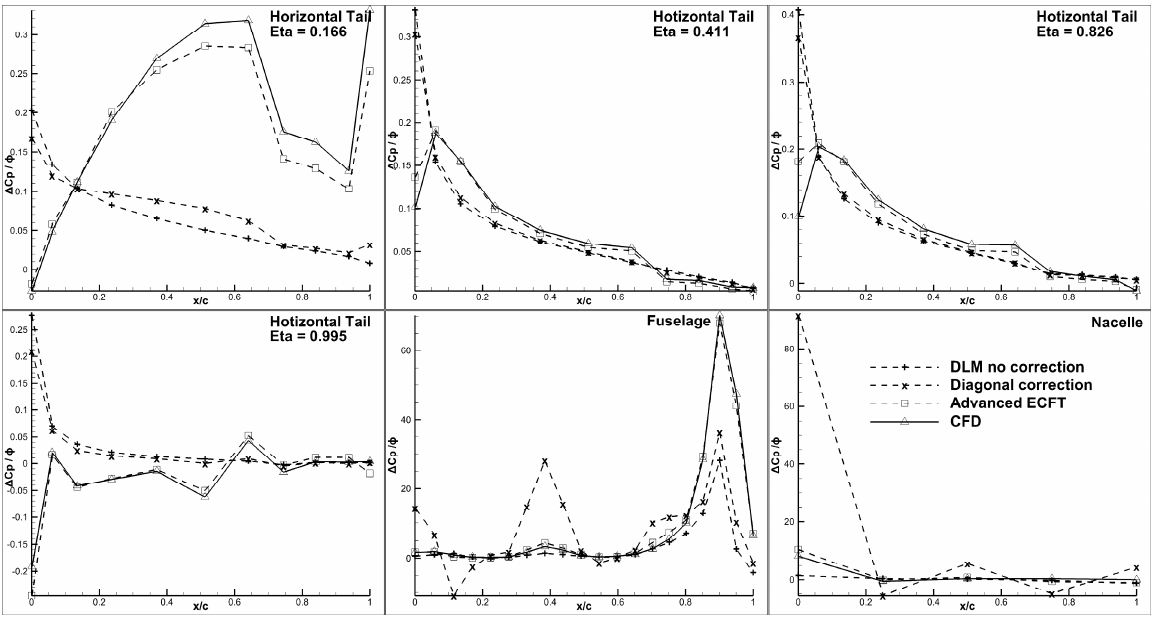
Aerospace 2023 , 10 , 40 Figure 10. Elastic Δ Cp for a unit α in the horizontal tail, fuselage, and nacelle component. Figure 10. Elastic ∆ Cp for a unit α in the horizontal tail, fuselage, and nacelle component.